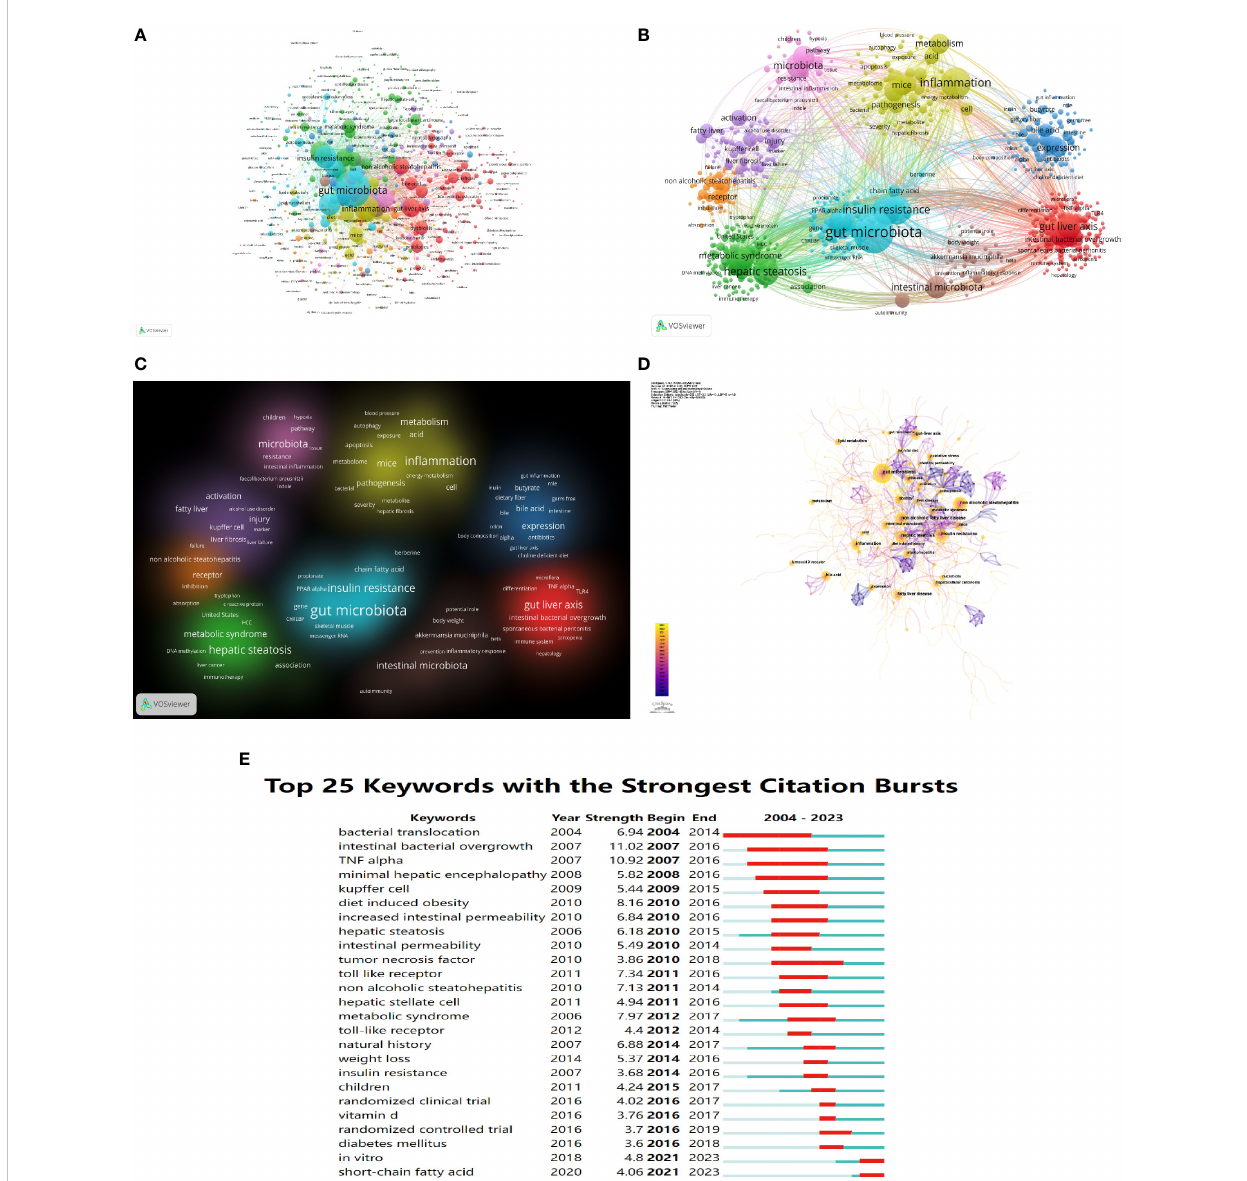
FIGURE 8 The mapping on keywords of the gut-liver axis research in NAFLD. (A) Network map of 701 keywords with frequency more than 5. (B) The cluster of keywords in the studies of the gut-liver axis in NAFLD (divided into 9 clusters by different colors.) (C) Density visualization of keyword clustering. (D) Visualization of keywords based on CiteSpace. (E) Top 25 keywords with the strongest citation